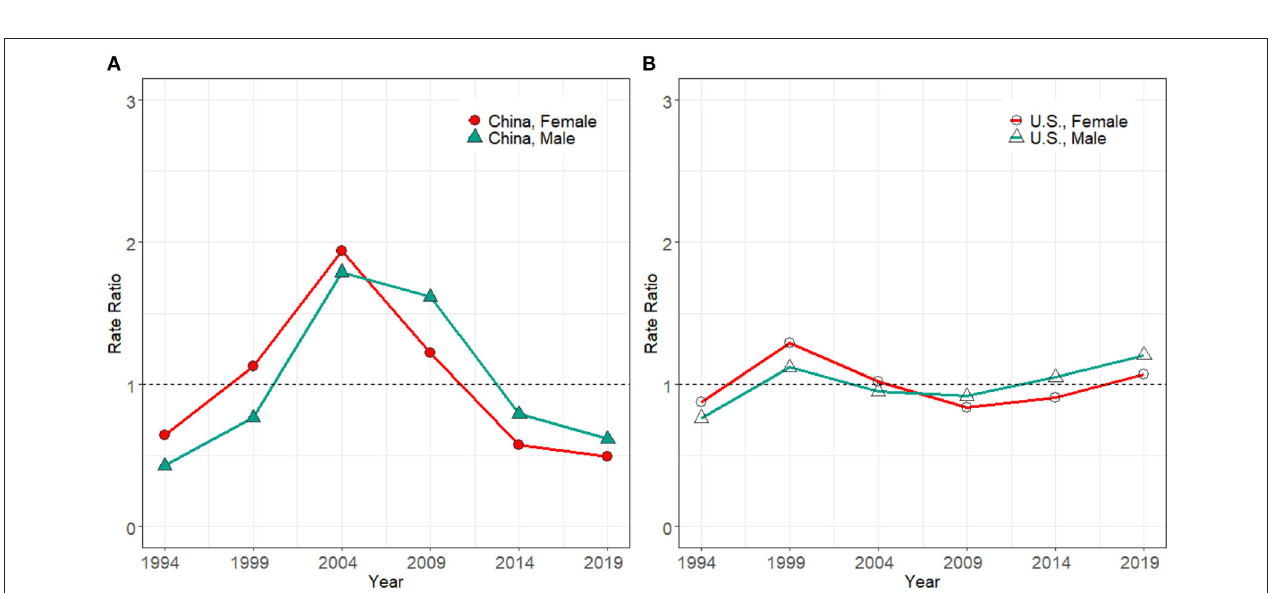
FIGURE 4 | Period effect on HIV/AIDS incidence rate for male and females in China (A) and the U.S. (B) , from 1994 to 2019.